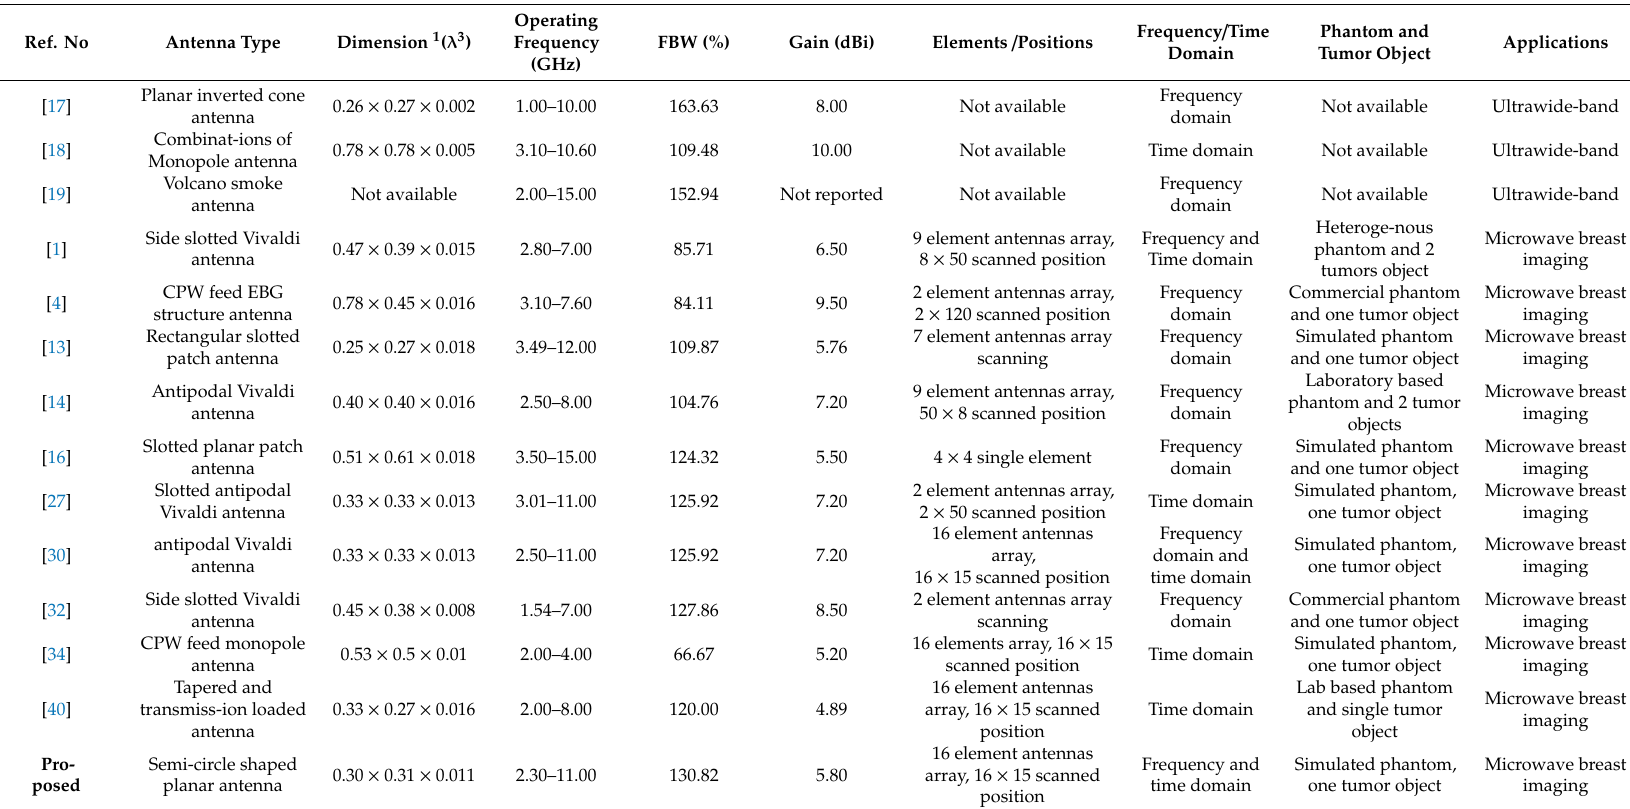
Table 4. Performance comparison outcomes among the reported antennas and the proposed